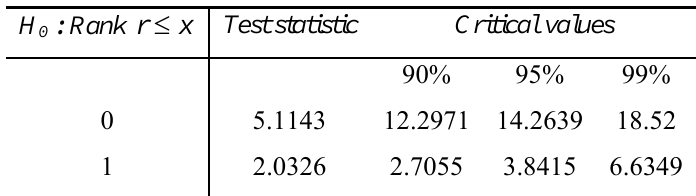
Table 5 Cointegration Tests for DJIA (with consumption data) Panel